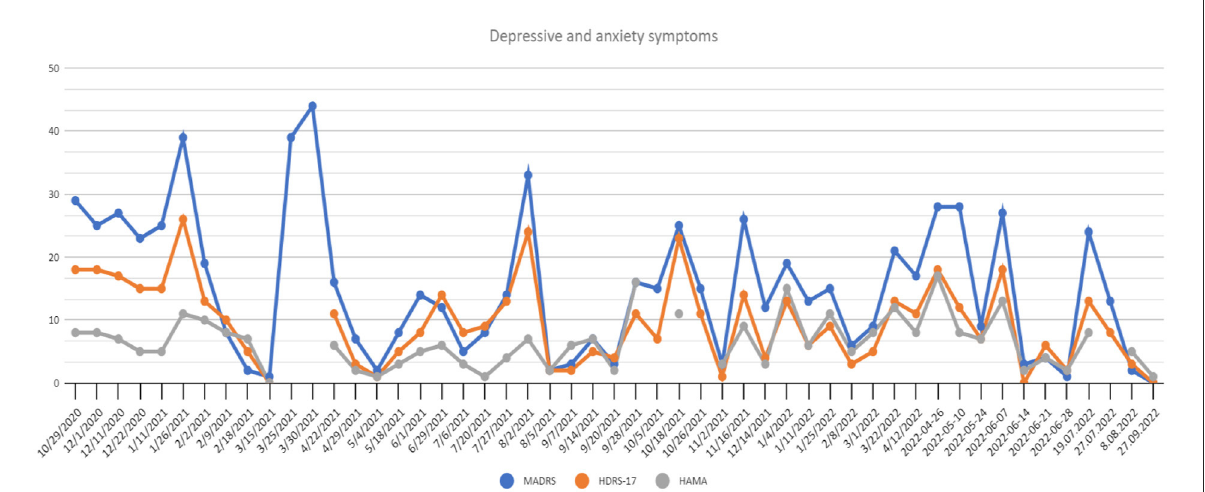
FIGURE2 Depressive and anxiety symptoms scores at recruitment point and during 20 months of active DBS stimulation period. HAMA, Hamilton Anxiety Rating Scale; HDRS-17, Hamilton Depression Rating Scale 17-item version; MADRS, Montgomery-Asberg Depressive Rating